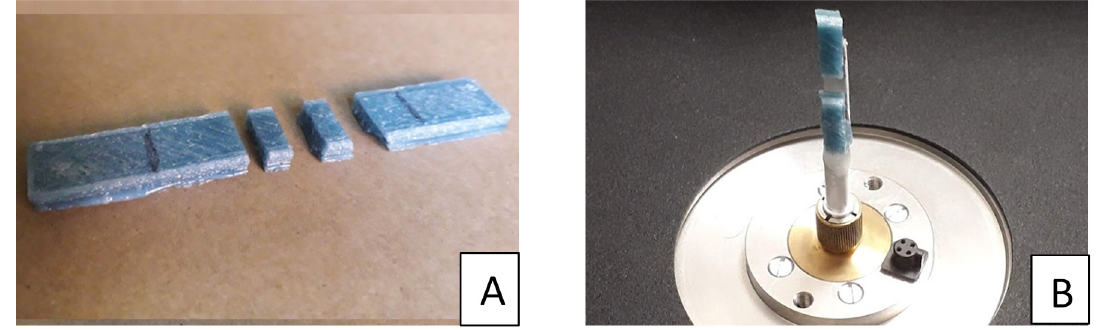
Figure 2. Cut samples for MICRO CT analysis ( A ) and housing in the tomograph holder ( B ).